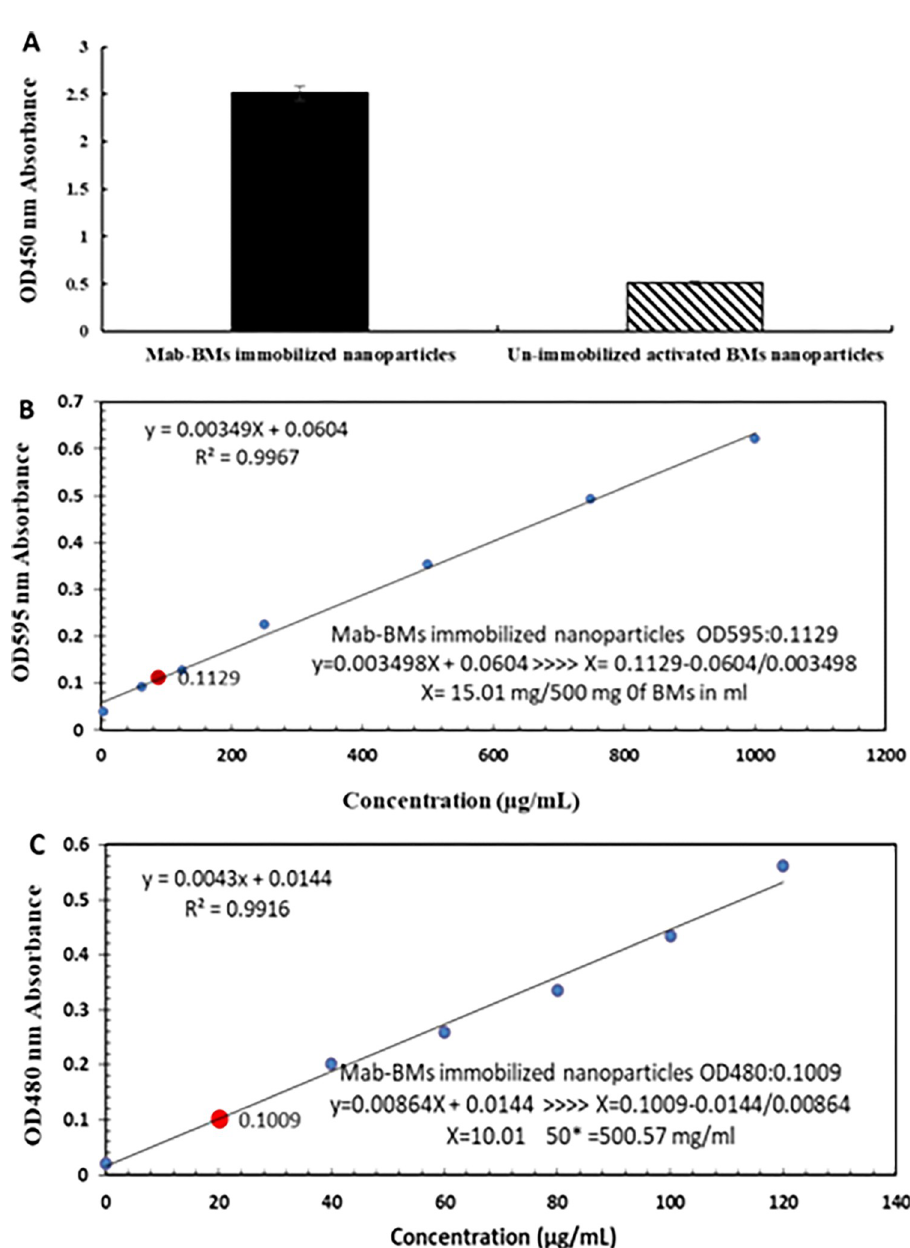
Fig 4. Optical absorption results of ELISA test to confirm the monoclonal stabilization of the target antibody on the nanoparticle. A) The optical absorption of the final product of the stabilized antibody on the magnetosome is 5 times higher than the activated magnetosome nanoparticles without antibody stabilization (negative control sample). B) Bradford assay showed an antibody concentration of 15.01 mg/500 mg BMs in ml. (C) BMs nanoparticles concentration of 500.57 mg/ml was obtained from potassium thiocyanate method. Strong confirmation has been made on the accuracy and performance of the stabilization process. In both experiments, results are based on a repetition as duplicate ( ± SD). BGG: Bovine gamma-globulin; BMs: Bacterial magnetosome; Mab: monoclonal